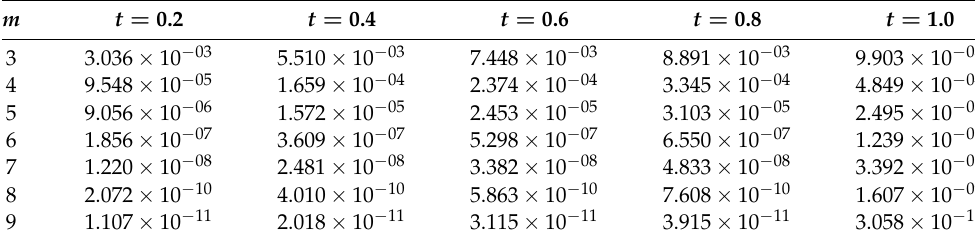
Table 3. The approximate solutions with different values for m at different times for Example 2. m t =